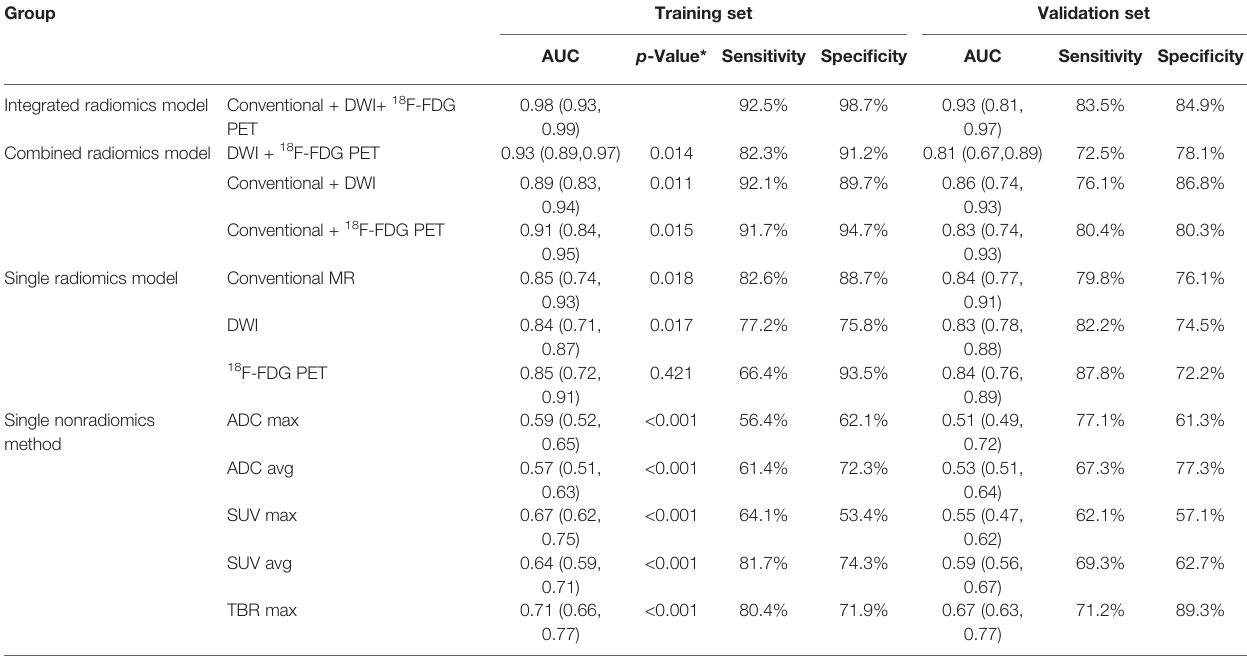
TABLE 3 | Comparison of diagnostic performance between integrated radiomics model and other methods in the training and validation sets.